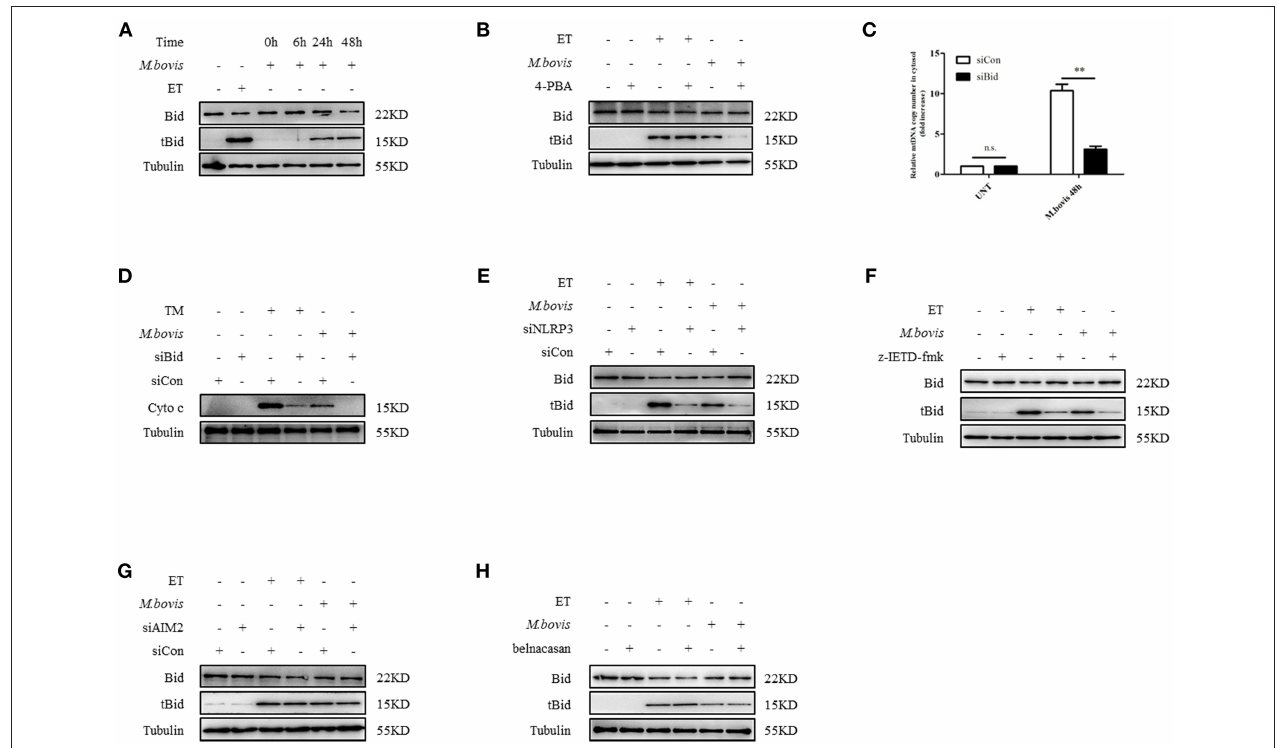
FIGURE 5 | NLRP3 and caspase-8 drive mitochondrial dysfunction through the pore-activating factor, Bid. (A) Immunoblot analysis at different time points of Bid in lysates of BMDMs infected with M. bovis (MOI 10). (B) Immunoblot analysis of Bid in lysates of BMDMs infected with M. bovis (MOI 10) in the presence or absence of 4-PBA. (C) qPCR analysis of mtDNA in cytosolic extracts from BMDMs transfected with control non-targeting siRNA (siCon) or Bid targeting siRNA (siBid) followed by M. bovis (MOI 10) infection for 48h. (D) Immunoblot analysis of cytochrome c in cytosolic extracts from BMDMs transfected with control non-targeting siRNA (siCon) or Bid targeting siRNA (siBid) followed by M. bovis (MOI 10) infection for 48h. (E) Immunoblot analysis of Bid in lysates of BMDMs transfected with control non-targeting siRNA (siCon) or NLRP3 targeting siRNA (siNLRP3) and then infected with M. bovis (MOI 10) for 48h. (F) Immunoblot analysis of Bid in lysates of BMDMs treated with or without z-IETD-fmk for 1h and then infected with M. bovis (MOI 10) for 48h. (G) Immunoblot analysis of Bid in lysates of BMDMs transfected with control non-targeting siRNA (siCon) or AIM2 targeting siRNA (siAIM2) and then infected with M. bovis (MOI 10) for 48h. (H) Immunoblot analysis of Bid in lysates of BMDMs treated with or without belnacasan for 1h and then infected for 48h with M. bovis (MOI 10). ET, etoposide, positive control for Bid truncation, 25 µ M; 4-PBA, 4-phenyl butyric acid, ERS inhibitor, 5mM; UNT, untreated; TM, tunicamycin, positive control for ERS induced mitochondrial damage, 10 µ g/ml, z-IETD-fmk, caspase-8 inhibitor, 50 µ M. Belnacasan, inhibitor of caspase-1, 20 µ M; siNLRP3, silencing RNA for NLRP3, 50nM; siAIM2, silencing RNA for AIM2, 50nM; siBid, silencing RNA for Bid, 50nM; siCon, non-targeting control siRNA, 50nM. MOI, multiplicity of infection. Data are representative of at least three independent experiments. The results are shown as the mean ± SD. ** P < 0.01, n.s., not significant. P -values were analyzed by using Student’s t